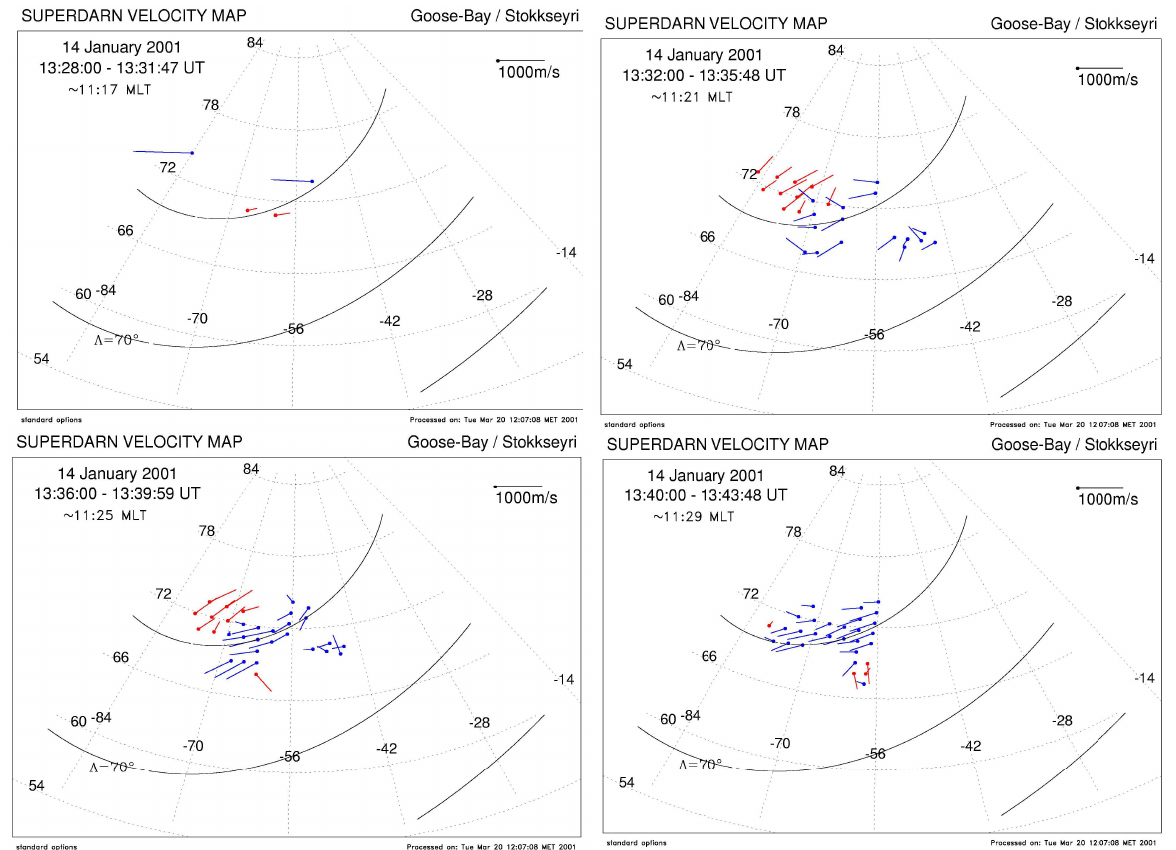
Fig. 8. Four examples of consecutive direct determinations of the horizontal ionospheric plasma flow from overlapping bi-static line-of-sight velocity measurements by the Stockseyri/Goosebay SuperDARN radar pair, overlooking the Greenland sector (compare with Fig. 2). The dot marks the origin of the velocity vectors, such that red vectors represent eastward plasma flow and blue vectors represent westward plasma